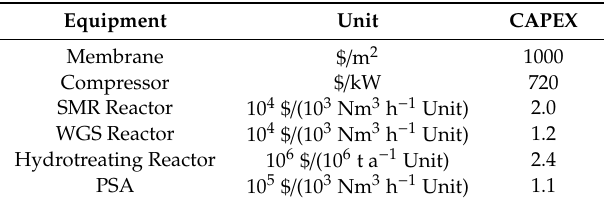
Table A1. Investment cost for key equipment.